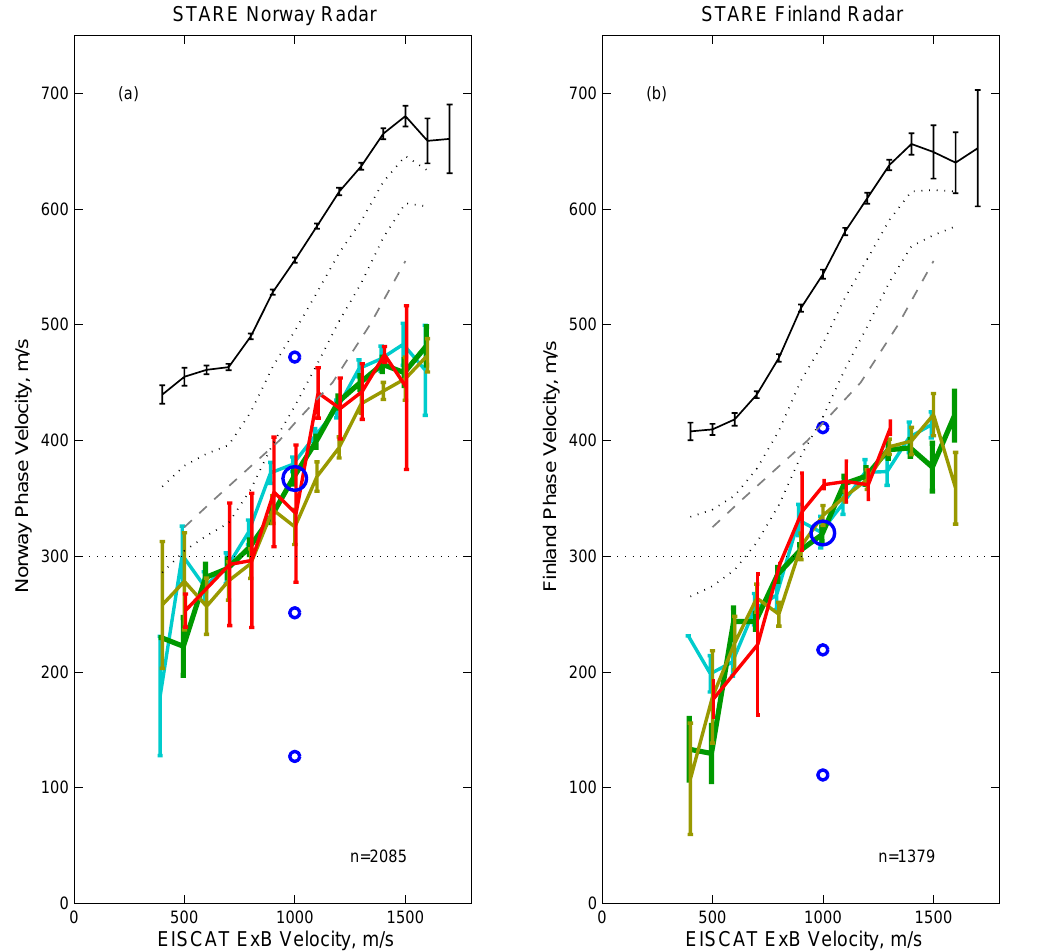
Fig. 4. Mean STARE irregularity drift velocities, V N and V F , (similar as Fig. 3) regrouped as a function of the EISCAT E × B electron irr irr drift velocity magnitude, V E × B ; (a) STARE Norway data and, (b) STARE Finland data, heavy green line is a reference dependence for the flow angle of 2 = 60 ◦ , light-blue line for 50 ◦ , yellow-green line for 70 ◦ and red line for 80 ◦ ; bars are the standard deviation of mean STARE velocities, thin black line with bars in upper part of figure is the mean EISCAT isothermal ion acoustic speed, C s , at altitude 111km, two grey dotted lines limit an interval between the 2 = 50 and 60 ◦ for the flow angle velocity dependence by Nielsen et al. (2002), dashed grey line is the mean STARE Doppler velocities inside the interval 2 = 30 − 60 ◦ by Nielsen and Schlegel (1985); blue circles illustrate a hypothetical case if a true flow angle cosine dependence would exist with respect to the arbitrary selected measured velocity at 2 = 60 ◦ and V E × B =1000m/s, large blue circle; smaller blue circles from the top to the bottom are the expected velocities for the flow angles 50, 70 and 80 ◦